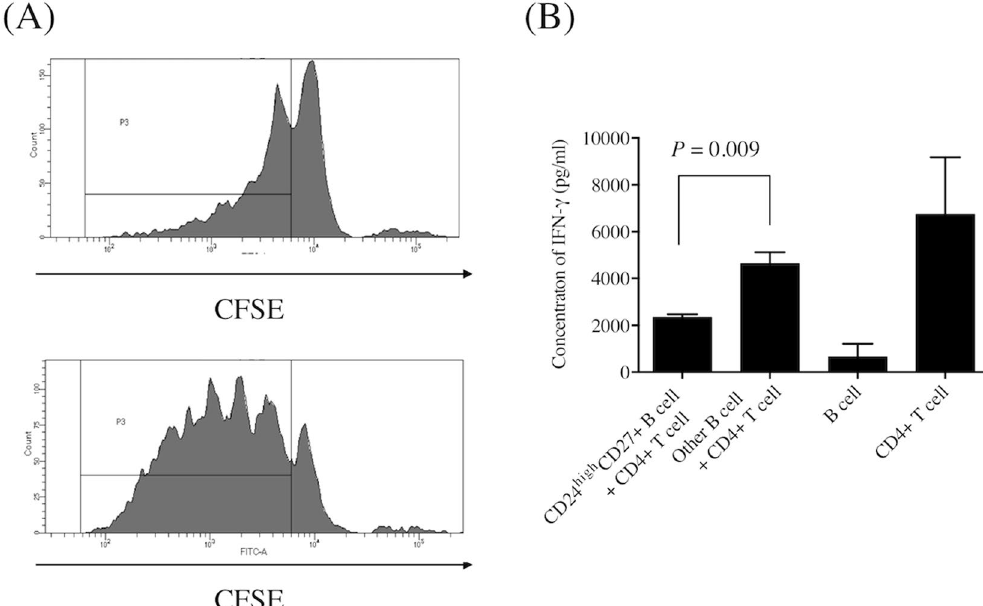
Figure 5. ( A ) Carboxyfluorescein succinimidyl ester cell division assay. The proliferation of CD4 + T cells co- cultured with CD19 + CD24 hi CD27 + B cells (upper panel) was lower than that of CD4 + T cells co-cultured with other B cells (lower panel). Image is representative of three experiments. The gate P3 indicates proliferated CD4 + T cells. ( B ) Enzyme-linked immunosorbent assay showing that IFN-gamma production by CD4 + T cells co-cultured with CD19 + CD24 hi CD27 + B cells was significantly lower than that of CD4 + T cells co-cultured with other B cells (n = 3).